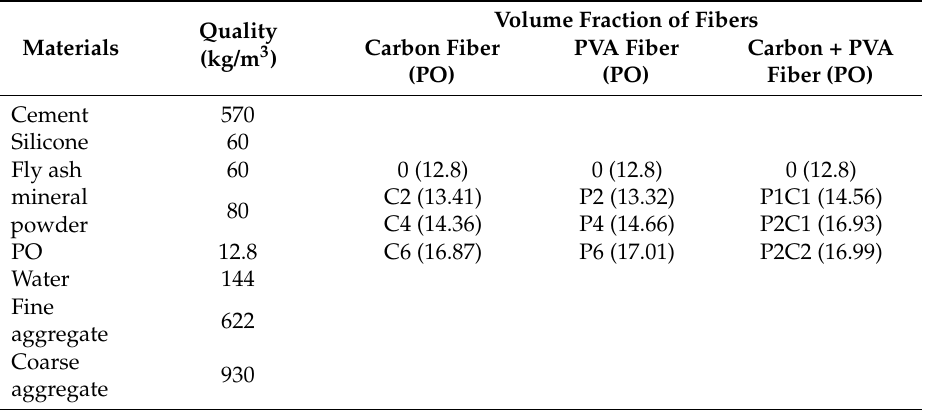
Table 1. The experimental